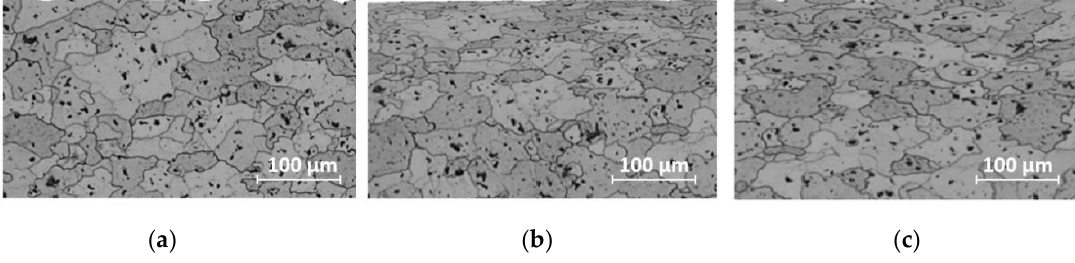
Figure 8. SEM images of the surface microstructure: ( a ) non-machined; ( b ) v c = 60 m/min and f = 0.15 mm/r; ( c ) v c = 40 m/min and f = 0.05 mm/r.